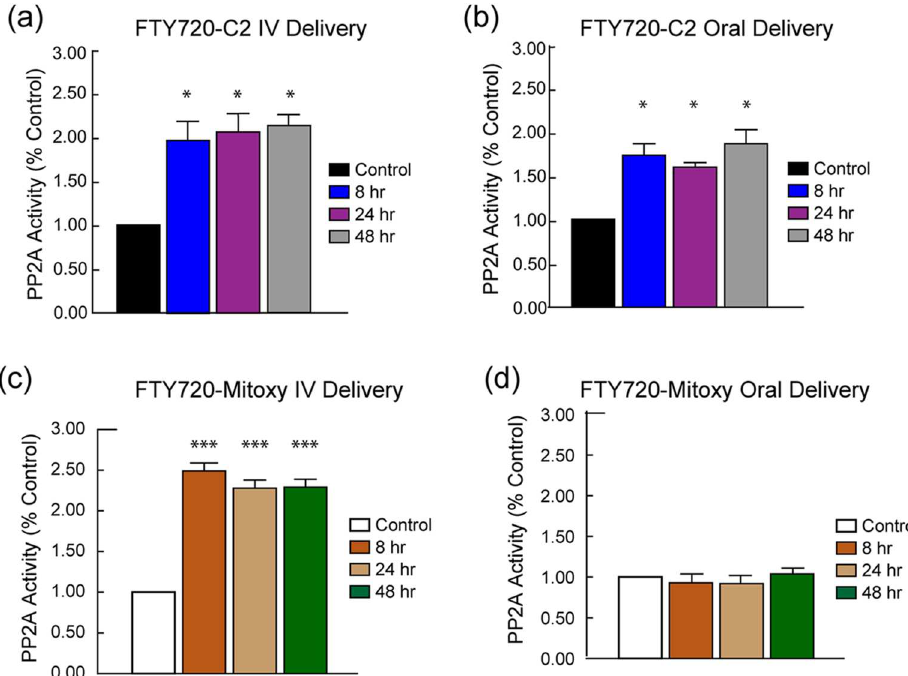
Fig 6. PP2A Activityin MouseAdrenalGlandafterIntravenous or Oral Dosing withFTY720-C2or FTY720-Mitoxy. FTY720-C2 increased PP2A activityin adrenal glands at all timepoints following IV delivery ( a ) and oral delivery( b )as comparedto untreatedcontrolmice. FTY720-Mitoxy increasedPP2A activity in the adrenalgland at all time points afterIV delivery( c ).Afteroral delivery, FTY7220-Mitoxy was not absorbed and adrenalPP2A activity did not increaseas comparedto untreatedcontrols( d ).Two mice per time point were evaluated. Data represent mean ± SEM.